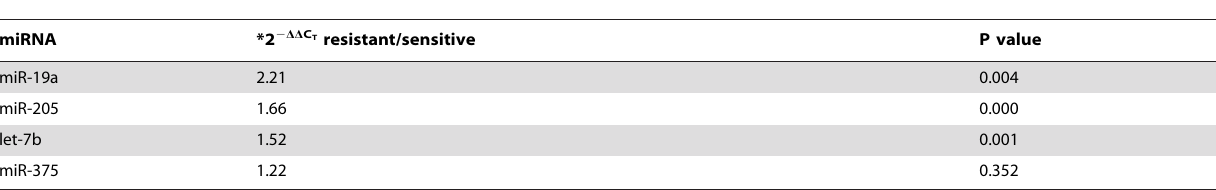
Table 3. Variation differences of 4 miRNAs.